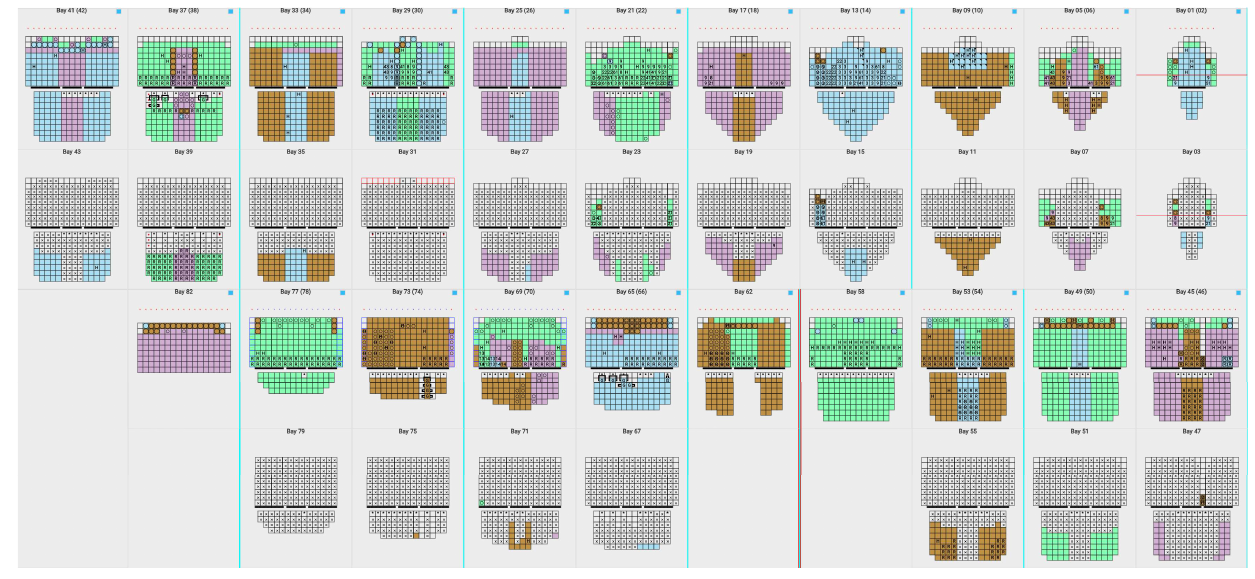
Figure 4. Stowage of 10,000 Twenty-foot Equivalent Unit (TEU) containership.